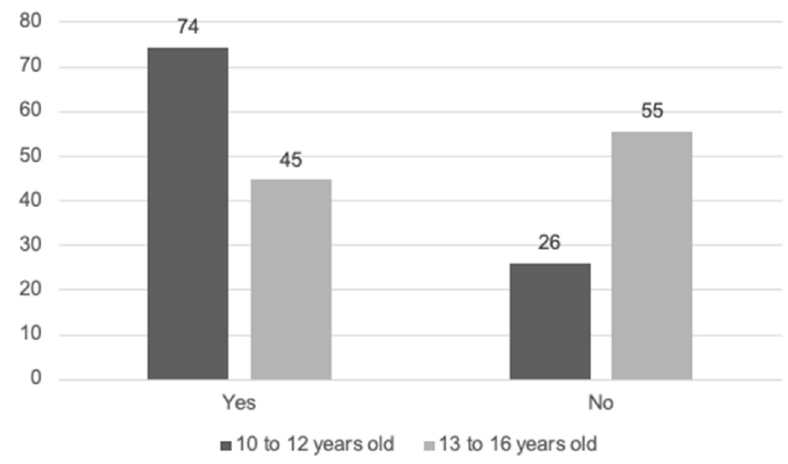
Figure 6. Content creation on TikTok (in percentage).